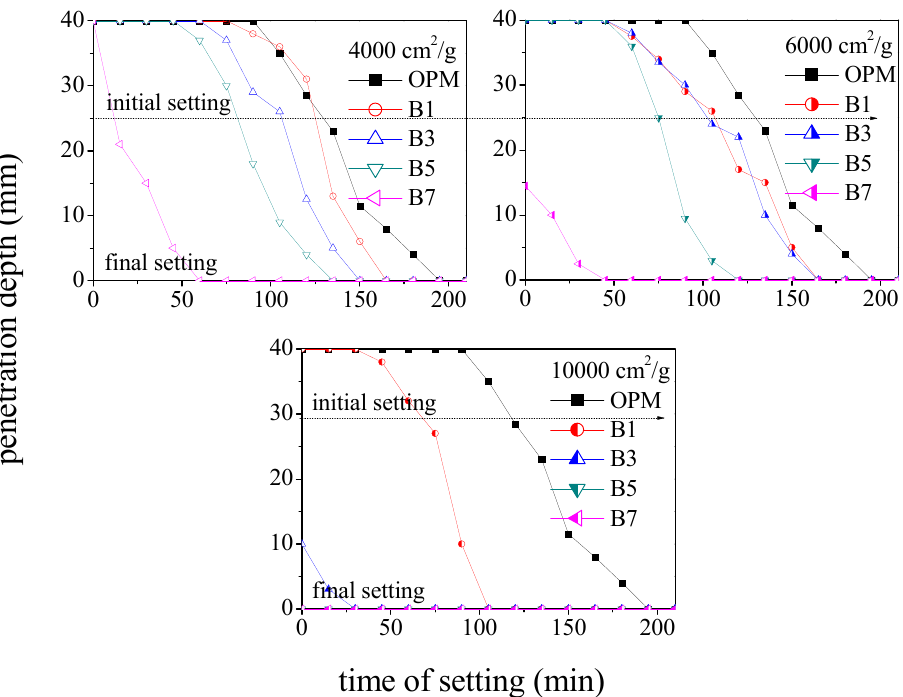
Figure 4. Setting times of samples made with BOFS of various specific surface areas.